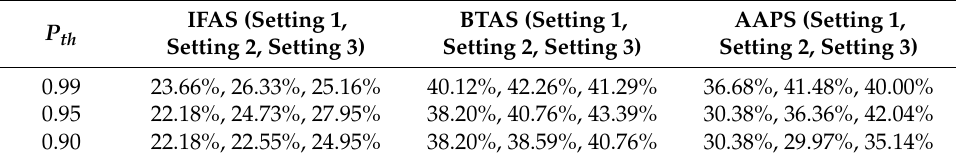
Figure 23. The average transmission times with P th as variable (setting 1, setting 2, setting 3). Table 14. The improvement of transmission times compared with the traditional algorithm.